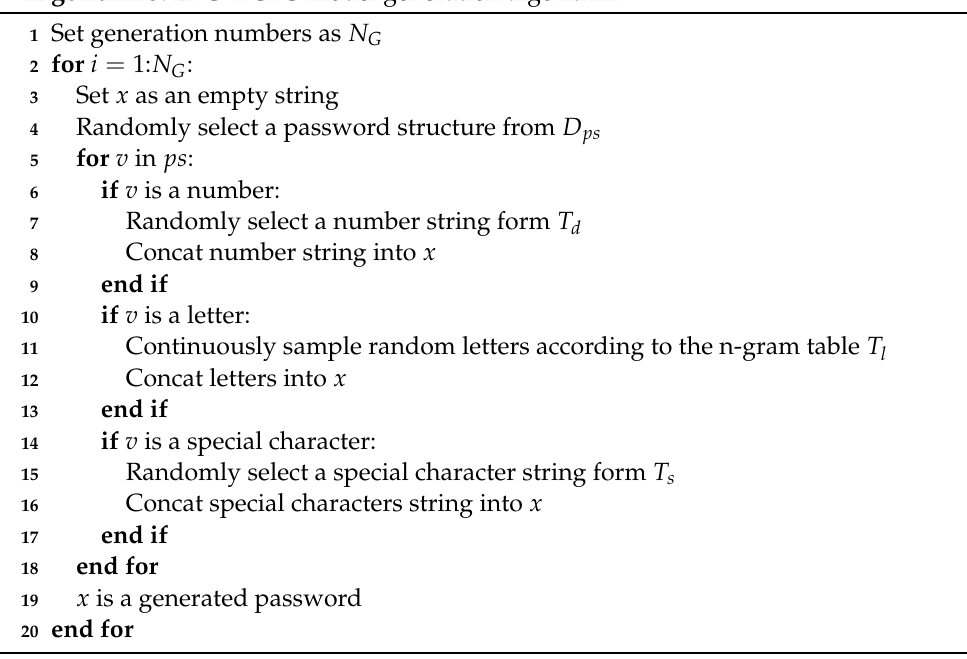
Algorithm 3: LPG–PCFG model generation